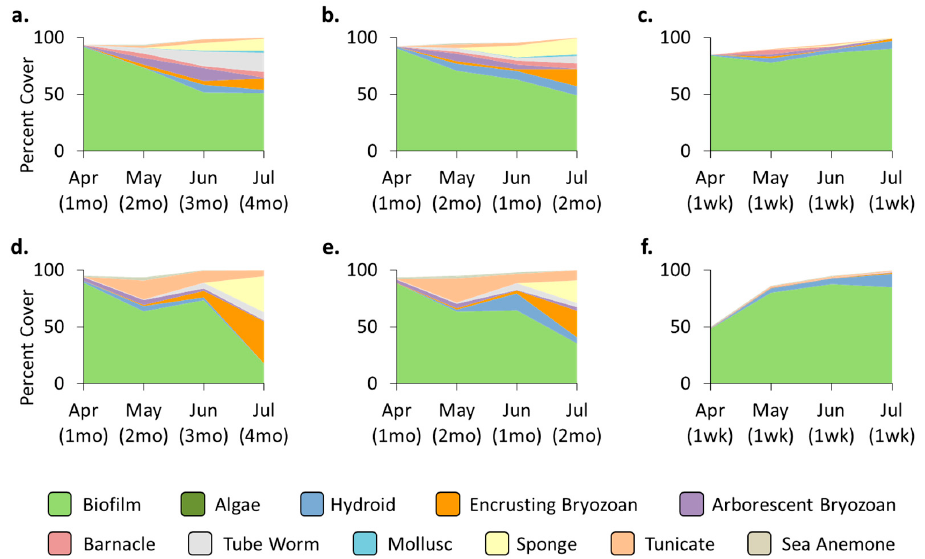
May, leveling out for June and increasing again in July. Groomed panels had very little cover of macrofouling and were dominated by biofilms. In July, the three treatments dif- fered primarily because of biofilms, encrusting bryozoans, tube worms (only uncleaned and cleaned), and sponges. cleaned), and sponges.